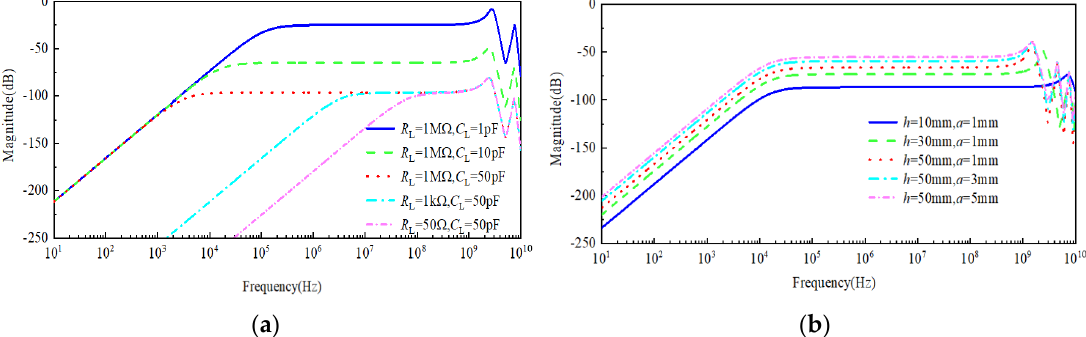
Figure 7. Frequency characteristic curve of the sensor under different load resistances ( a ) and different sizes of antenna ( b ).